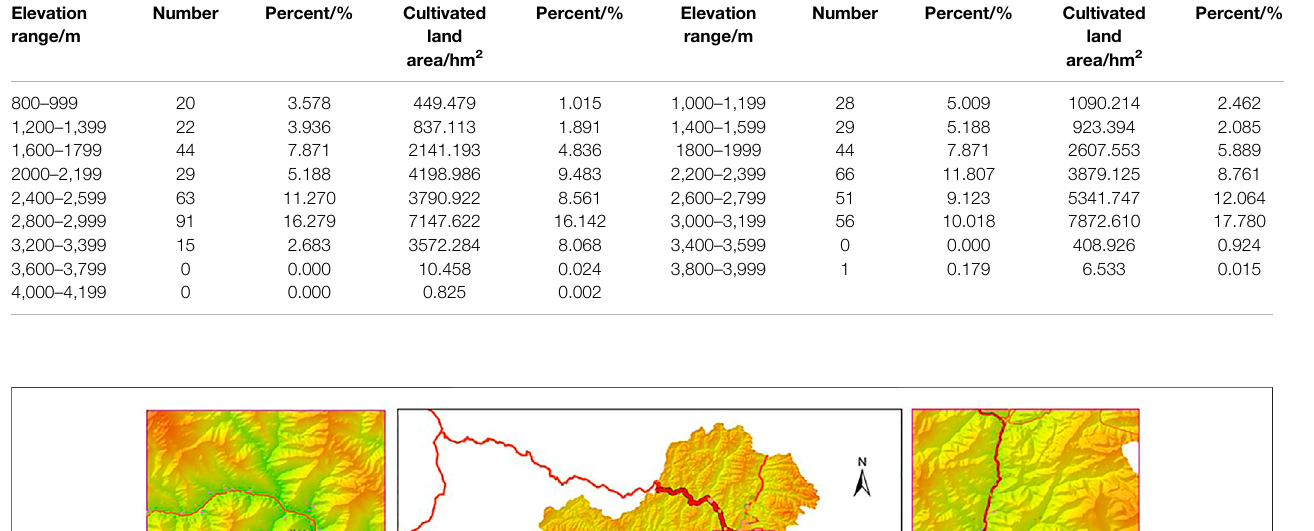
TABLE 2 | Distribution of settlement numbers and cultivated land area with elevation in the upper reaches of the Min river. Elevation range/m